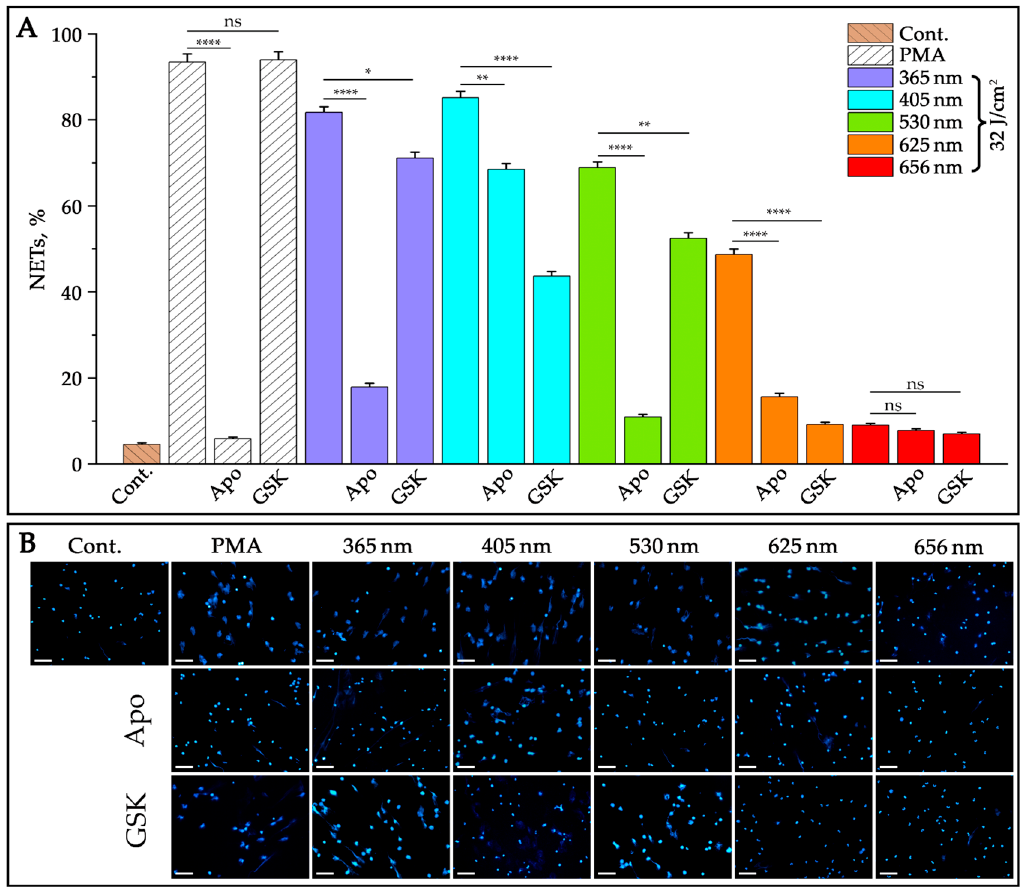
Figure 5. Effects of selective inhibitors of NADPH oxidase and PAD4 on NET formation in neutrophils irradiated with fi ve LED-lengths and the same energy dose. Neutrophils isolated from the blood of healthy donors were treated with selective inhibitors of NADPH oxidase (apocynin, 400 µM) and PAD4 (GSK484, 10 µM) for 30 min. NET formation was induced by irradiation with LED-lights of 365, 405, 530, 625, and 656 nm and the same energy dose of 32 J/cm 2 . PMA (50 nM) was used as a positive control. After incubation for 3 h, the cells were stained with DAPI and analyzed using fl uorescence microscopy. The data represent the mean ± SD from fi ve independent experi- ments ( n = 5). Statistically signi fi cant p values are indicated as follows: * p < 0.05, ** p < 0.01, and **** p < 0.0001. Insigni fi cant di ff erences are marked as “ns” ( A ). Representative fl uorescence images of NET formation after neutrophil treatment with inhibitors and irradiation with LED-lengths are shown. Scale bars: 50 µm ( B ).